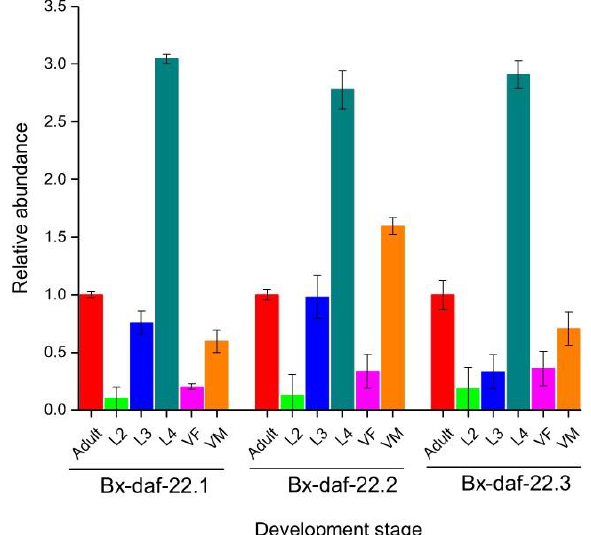
Figure 3. Transcriptional levels of Bx-daf-22 genes at different developmental stages of B. xylophilus . The abundance of gene expression was quantified by quantitative real-time PCR (qRT-PCR) in different developmental stages and sexes of B. xylophilus : second-stage (L2), third-stage (L3), fourth-stage (L4), virgin female (VF), virgin male (VM), and adult. All gene expression levels were normalized to the β -actin gene.